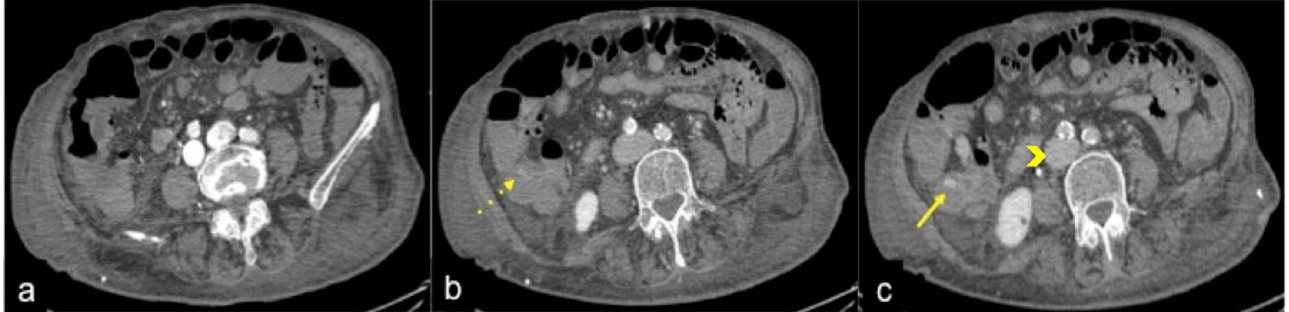
Figure 4. CTA multiphasic study of the haemorrhagic spot in the ascendant colon of a patient with heart failure. In the arterial phase of study ( a ), no signs of bleeding are evident. The venous phase ( b ) shows a hyperdense endoluminal blush of contrast media (discontinuous arrow) that is more evident in the successive phase (( c ) arrow). CT multiphasic findings are suggestive of low-flow active bleeding in a patient with heart failure: note the inferior cava vein dilatation (( c ) arrowheads).